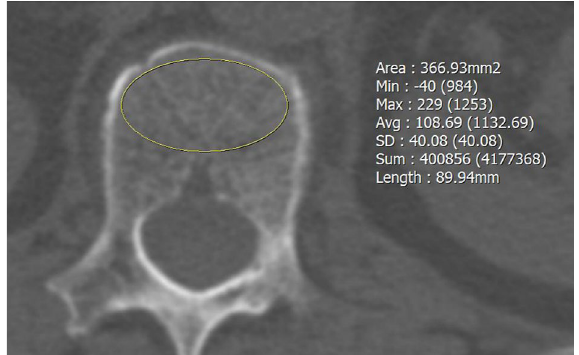
Figure 2. Example of CT Hounsfield unit (HU) measurement in an axial image of an upper instrumented vertebra at the mid-body level. The mean HU value was automatically derived by the picture archiving and communication system. Min minimum, max maximum, avg average, SD standard deviation.